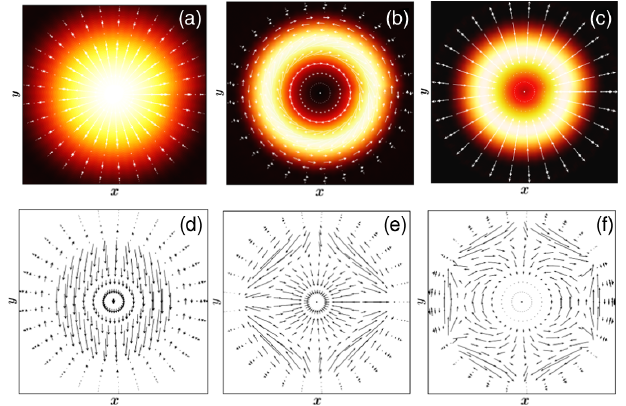
7. (a)-(c) show the intensity and transverse vector field ⃗ I ˆ e (white arrows, þ I n − ˆ e − ) of radiation for the funda- ⊥ ¼ I n þ þ mental ( n ¼ 0 ), second ( n ¼ 1 ), and third ( n ¼ 2 ) harmonics, respectively in Eq. (24) and (25), viewed along z -axis; (d)-(f) show the corresponding rotation